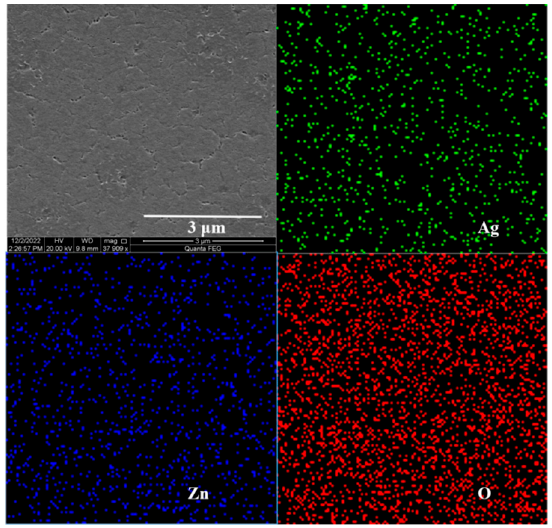
Figure 2. SEM characterization and EDS mapping of Zn 0.95 Mg 0.05 O films modified by Ag NPs.